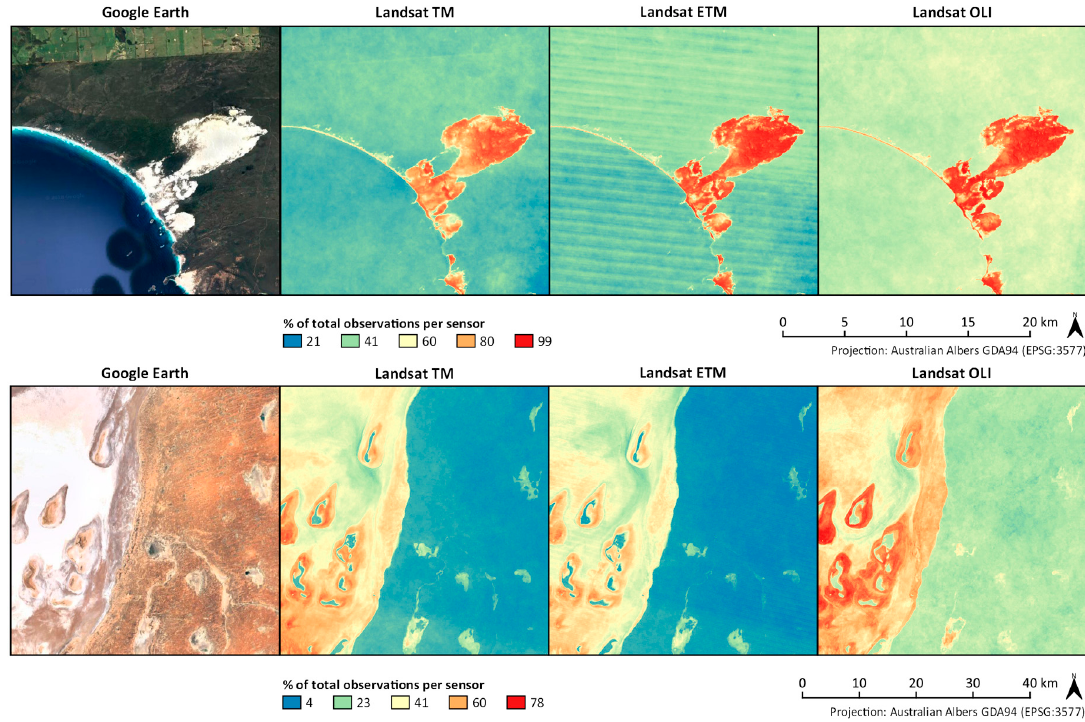
Figure 3. Fmask cloud flags (in percent of total observations) for Landsat TM, ETM, and OLI for Cape Arid and Lake Frome. High-resolution imagery: Google, CNES/Airbus, TerraMetrics, DigitalGlobe.